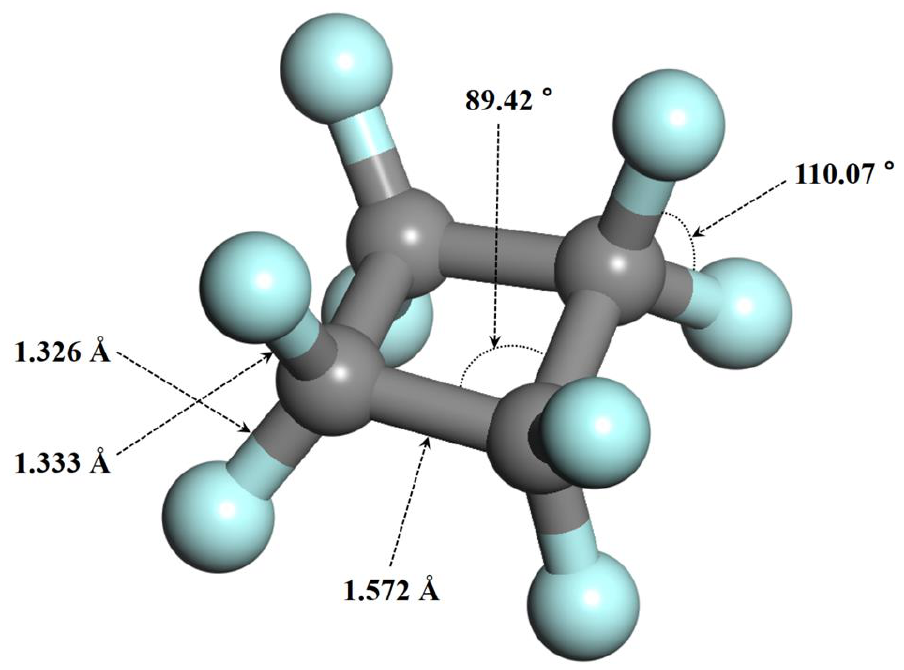
Figure 1. Equilibrium structure of neutral c -C 4 F 8 at ωB97X-D/aug-cc-pVTZ. The ring-puckering angle is 16.33°.